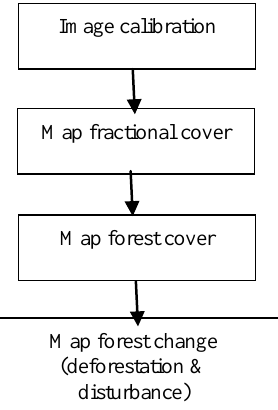
Figure 2. CLASlite steps for the image